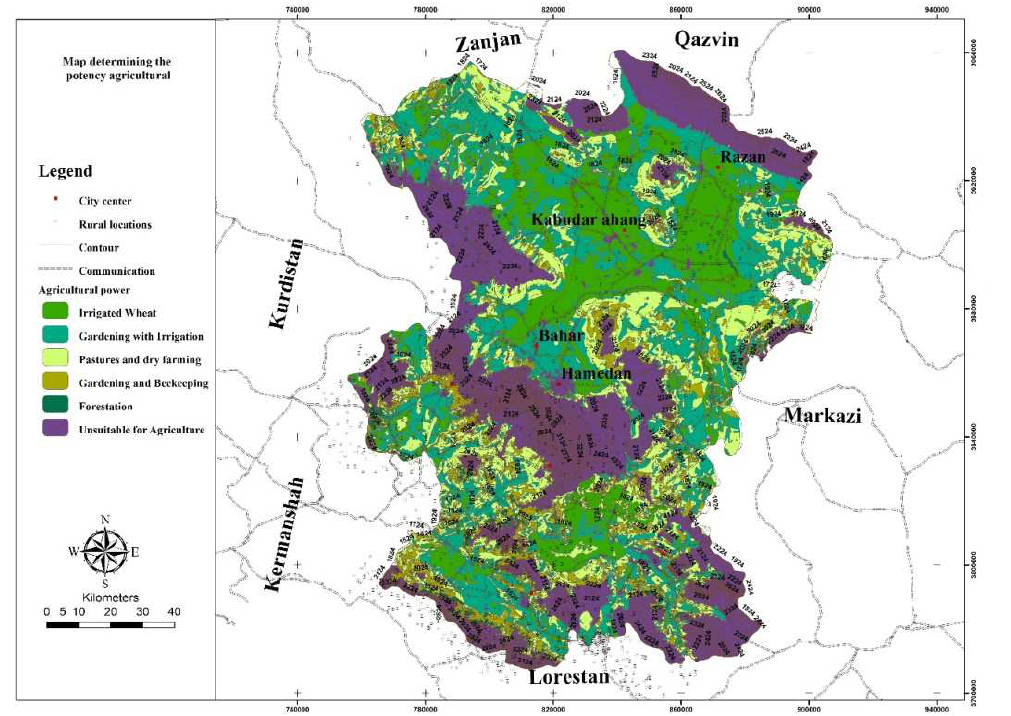
Figure 6. Map of different levels of agriculture